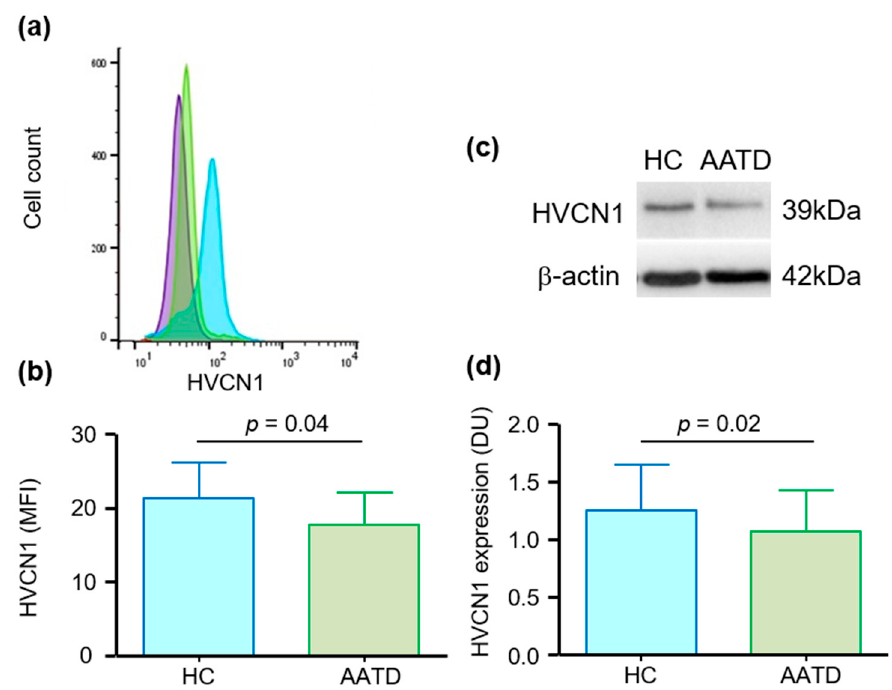
Figure 1. Reduced voltage-gated hydrogen channel 1 (HVCN1) in neutrophils of individuals with alpha-1 antitrypsin deficiency (AATD). ( a ) Representative flow cytometry data histogram showing abundance of cell surface HVCN1 in healthy control (HC) (blue) and AATD (green) neutrophils compared to the isotype control (purple). ( b ) Neutrophil membrane levels of HVCN1 quantified by flow cytometry were expressed as mean fluorescence intensity (MFI). Graph illustrates a significantly lower abundance of HVCN1 in AATD neutrophils ( n = 9 subjects per group, p = 0.04, Student’s t test). ( c ) Representative Western blot depicting HVCN1 expression in neutrophil whole cell lysates. β -actin was used as a loading control. ( d ) Graph depicting densitometry units (DU) for HVCN1 immunobands, showing significantly decreased protein level of HVCN1 in neutrophil whole cell lysates of individuals with AATD compared to HC ( n = 7 subjects per group, p = 0.02, Student’s t test).